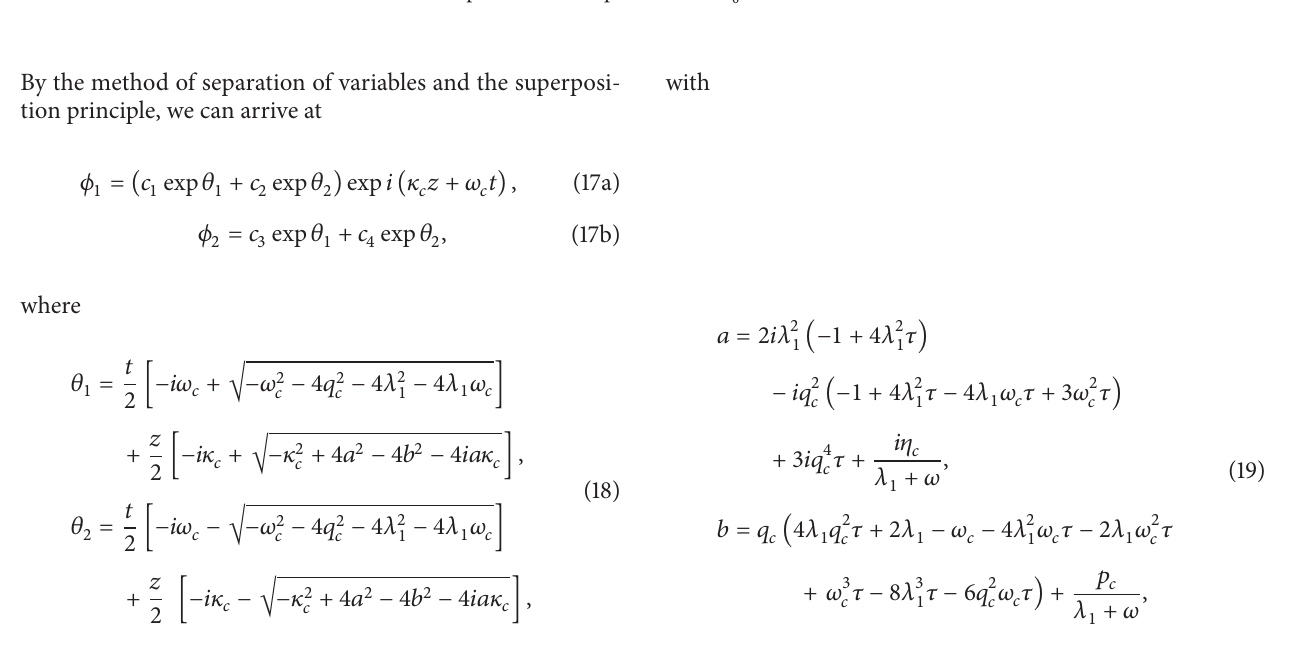
Figure 5: The parameters adopted here are 𝑡 0 = 10 , 𝜔 = 3 , and 𝜏 = 0